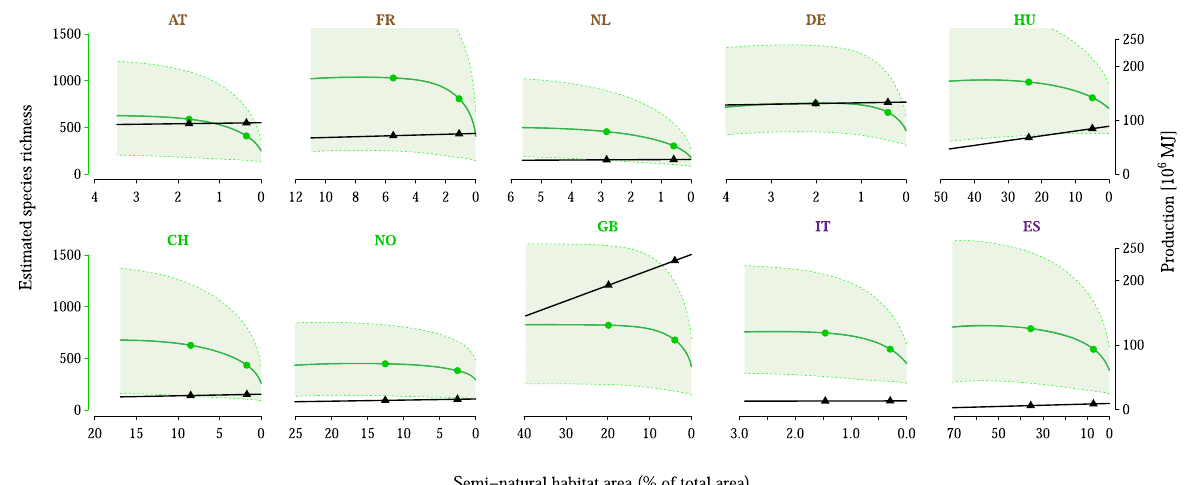
Fig. 2 Estimated species richness and production for gradual conversion of semi-natural habitats to production fi elds in ten European farmland regions (brown: arable crops, mixed systems and horticulture, bright green: grassland, violet: permanent crops). The effect of the conversion of semi- natural habitats (percentage of the total farm area) on species richness (green lines, sum of vascular plant, earthworm, spider and wild bee species) is estimated with backward sample-size-based extrapolations 31 of species unique to semi-natural habitats and addition of species unique to production fi elds and species shared (Methods). Con fi dence intervals (95%) are the sum over the con fi dence intervals of the four species groups. Effect on production (black lines) is calculated by multiplying the converted semi-natural area by the overall yield of the region. Effects of a 50% and 90% conversion of the semi-natural area are indicated for species richness (green dots) and production (black triangles) (Supplementary Table